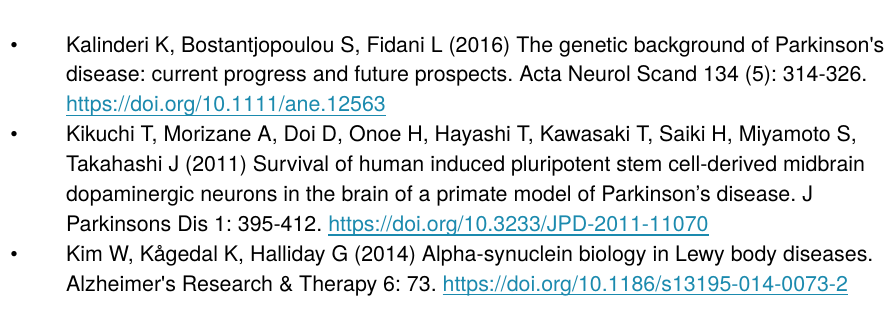
hiPSC-derived DA Neuron Transplantation: GFP-labeled post-grafted DA neurons immunohistochemical staining for α -synuclein, the phenomenon of transmission of endogenous Lewy body-like α -synucleinopathies is evaluated. Epigenetic Genomic